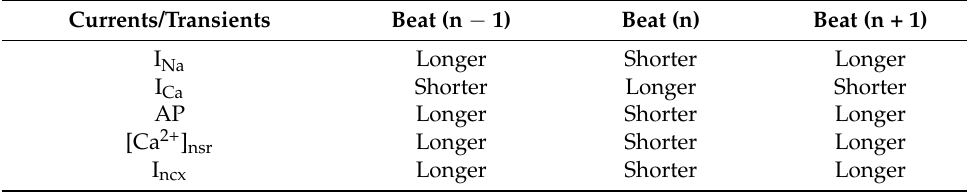
Table 6. Alternating ionic currents and transients in consecutive beats.